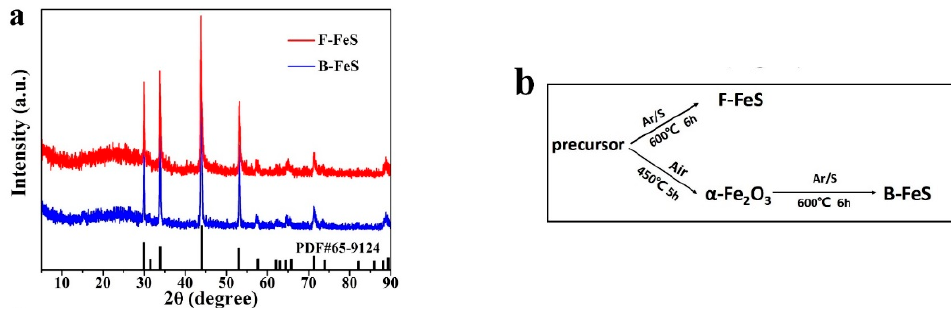
Figure 1. ( a ) XRD patterns of the as-prepared F-FeS and B-FeS; ( b ) Schematic illustration of the calcination process.